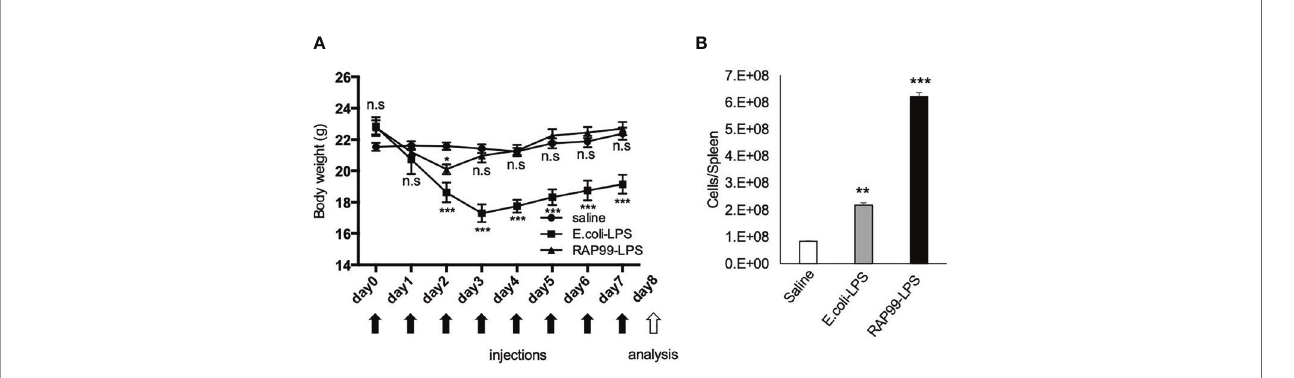
FIGURE 3 | RAP99-LPS treatment induced immune activation. E. coli -LPS (200 m g/day), RAP99-LPS (200 m g/day), or saline was intraperitoneally injected into C57BL/6 mice for 8 days to investigate (A) body weight and (B) the number of splenocytes. Mice injected with E. coli -LPS and RAP99-LPS were compared to mice injected with saline. Mean scores ± SD are shown. **p < 0.01; ***p < 0.001; n.s., not signi fi cant; Student ’ s t tests. Saline (n = 4), E. coli -LPS (n = 5), RAP-LPS (n = 5). Black arrows: injections. White arrow: analysis. (Representative data are shown.)